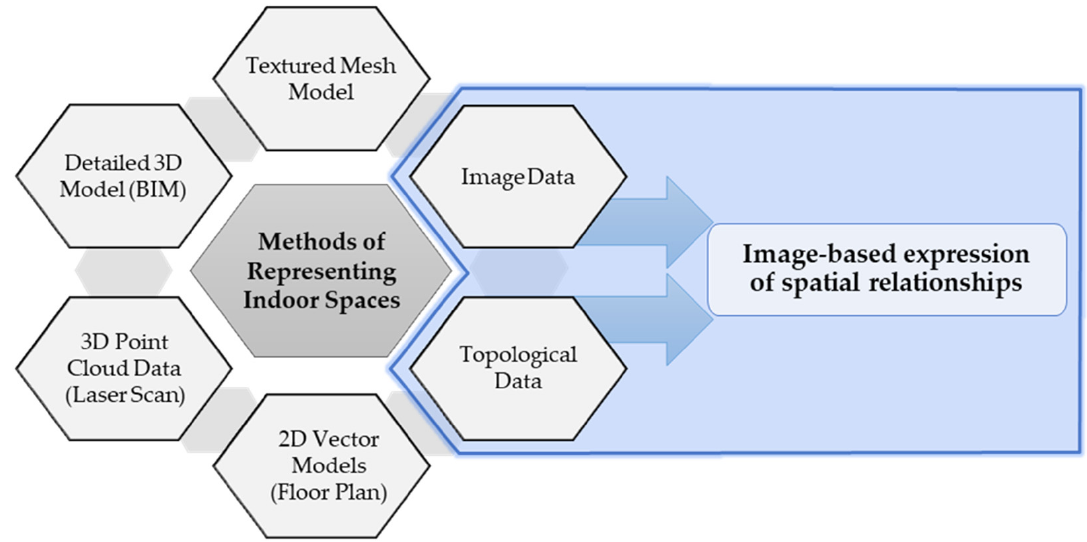
Figure 1. Various methods of representing indoor spaces using spatial data.